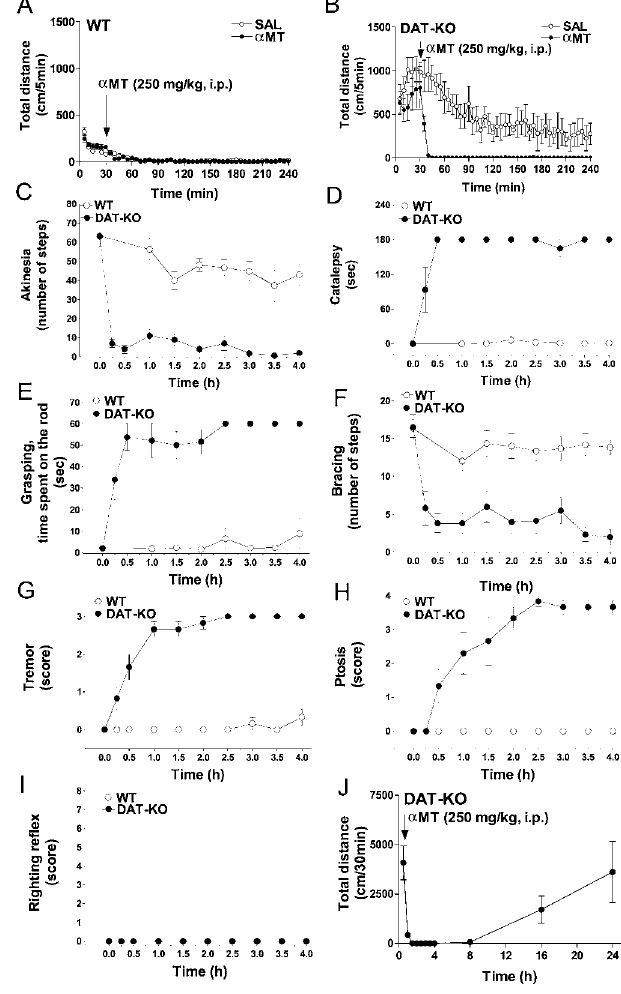
Figure 3. a MT-Induced Impairment in Motor Control in DAT-KO Mice Dynamics of locomotor activity following systemic administration of a MT (250 mg/kg IP) and saline (30 min after placement in the locomotor activity chamber) in WT (A) and DAT-KO (B) mice ( n ¼ 6–8 per group). Analysis of total distance traveled for 210 min after drug administration revealed significant effect of a MT treatment ( p , 0.05; Student’s t -test) in DAT-KO but not WT mice (WT-saline, 516 6 50 cm/210 min; WT- a MT, 505 6 98 cm/210 min; DAT-KO–saline, 18,489 6 4,795 cm/210 min; DAT- KO– a MT, 448 6 75 cm/210 min). a MT (injected at time 0)